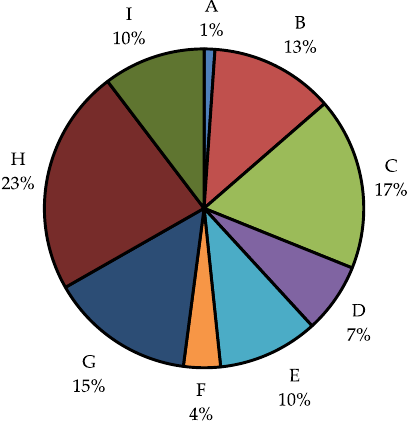
Figure 9. Average mass of each fraction. Fractions G, H, and I comprise almost 50% of the mass, while fractions A, D, and F comprise less than 15%.